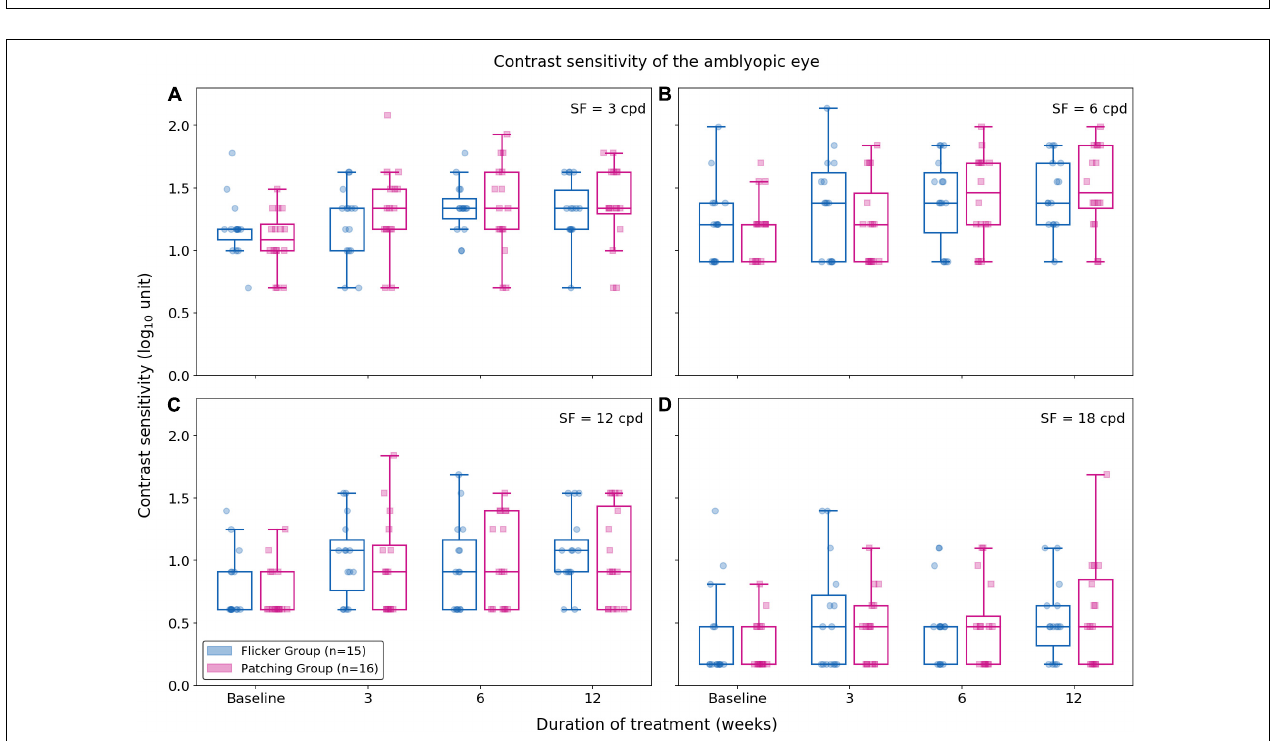
FIGURE 3 | Contrast sensitivity at 3, 6, 12, and 18 cpd (cycles per degree) for each treatment group. Blue plots represent the Flicker Group, and pink plots the Patching Group. Circles represent the contrast sensitivity of patients in the Flicker Group, and squares the contrast sensitivity patients in the Patching Group. (A) Contrast sensitivity for 3 cpd. (B) Contrast sensitivity for 6 cpd. (C) Contrast sensitivity for 12 cpd. (D) Contrast sensitivity for 18 cpd.